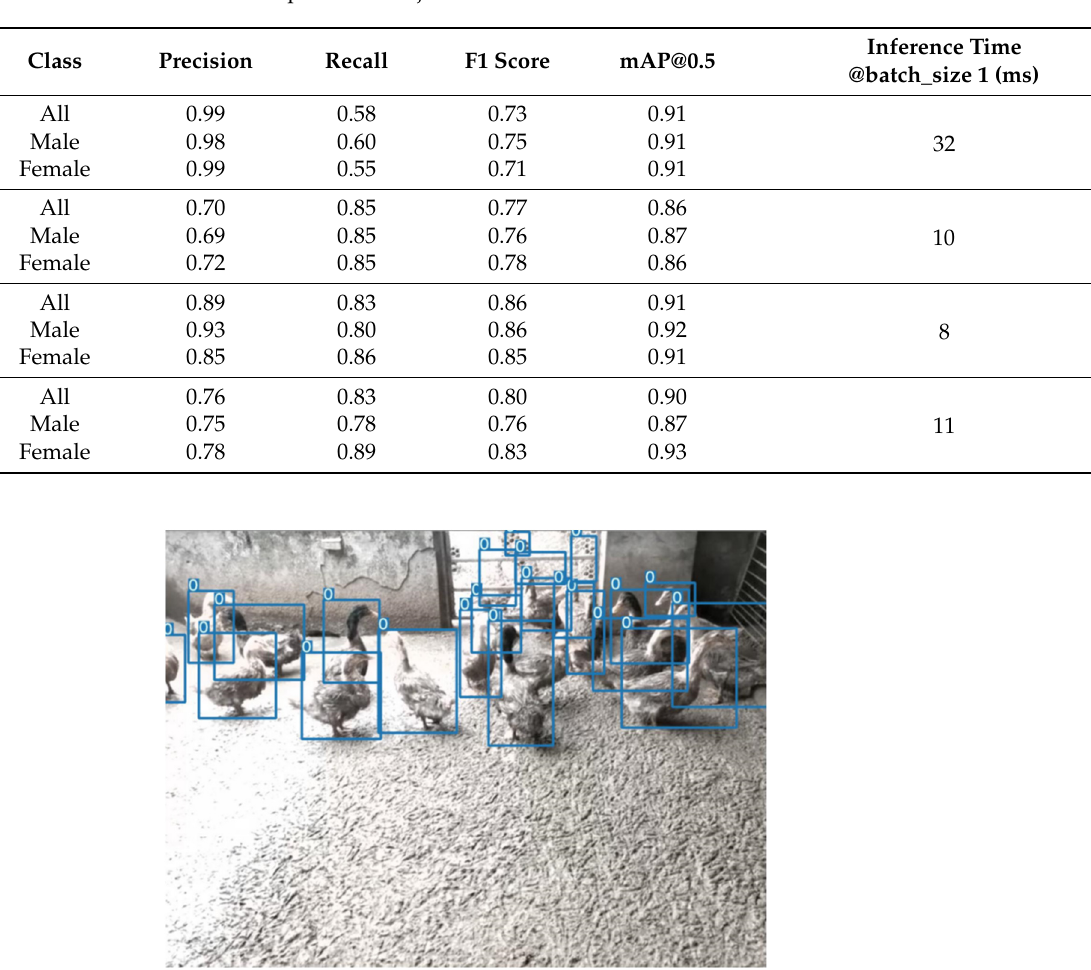
Table 2. Comparison of object detectors in the whole-duck dataset.